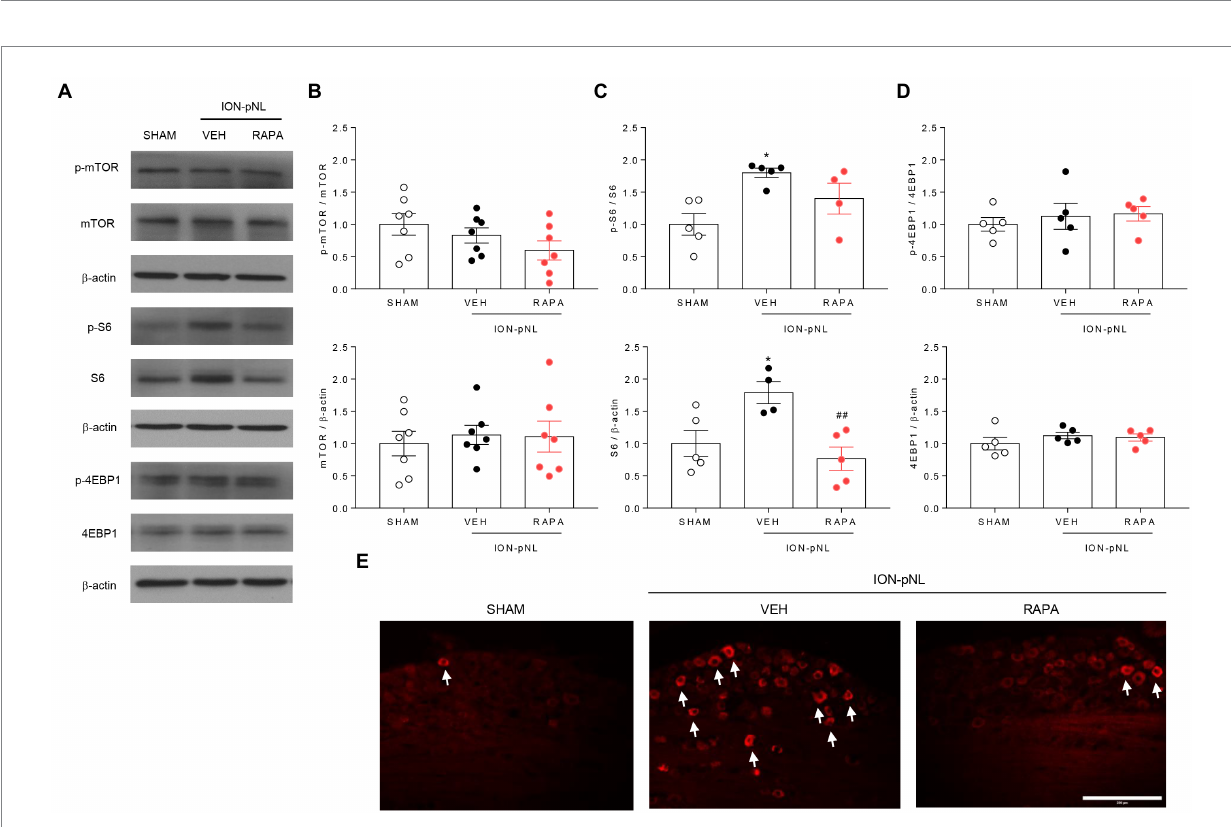
FIGURE 4 Expression of p-mTOR signaling-related proteins in the trigeminal ganglion (TG). The expression of mTOR, 4EBP1, and their phosphorylated forms (p-mTOR and p-4EBP1) did not change in the ION-pNL group compared with the SHAM group, and the RAPA group also showed no significant change compared with the VEH-treated group (A,B,D) . Conversely, the expressions of S6 and p-S6 were significantly increased in the ION-pNL group compared with the SHAM group (* p < 0.05), and rapamycin reduced the increased expressions of S6 and p-S6 in the TG (A,C) . ## p < 0.01 compared with VEH. Immunohistochemistry also showed an increase in the expression of p-S6 in the ipsilateral TG of the ION-pNL group compared with the SHAM group, and this increased p-S6 expression was reduced by rapamycin treatment (E) , The arrows indicate representative p-S6-immunoreactive cells. n = 4–7 per group. Scale bar = 200 μ